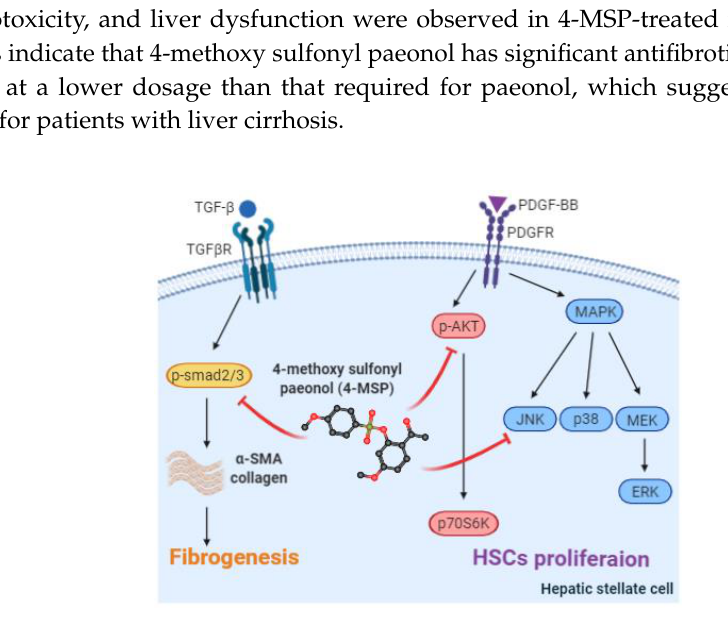
Figure 6. Proposed model of compound 4-methoxy sulfonyl paeonol (4-MSP) in the inhibition of HSCs proliferation and fibrogenesis. Compound 4-MSP causes inhibition of hepatic stellate cells (HSCs) activation and liver fibrosis by blocking TGF- β1/Smad , PDGF-BB/MAPK, and Akt signaling pathways.